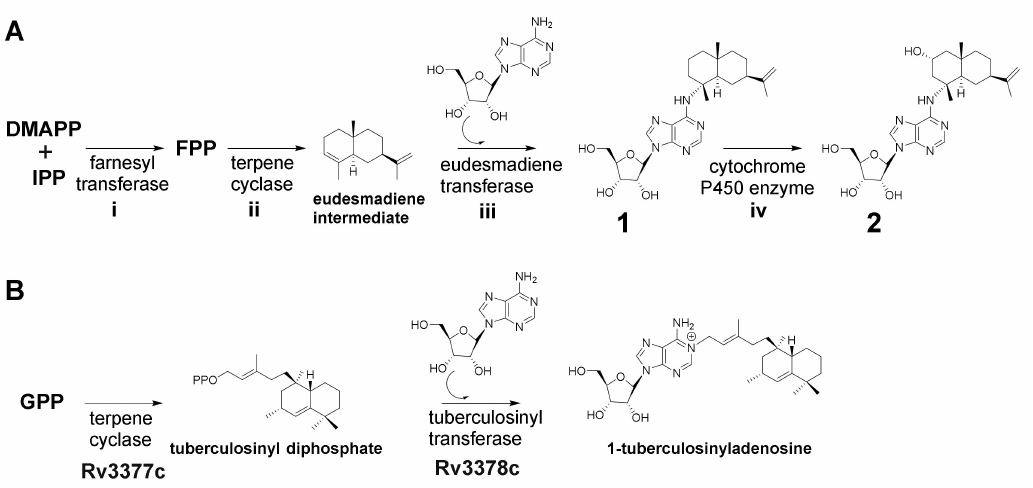
Figure 4. ( A ) Proposed biosynthetic route to 1 and 2 based on retrobiosynthetic considerations. ( B ) Biosynthesis of 1-tuberculosinyladenosine